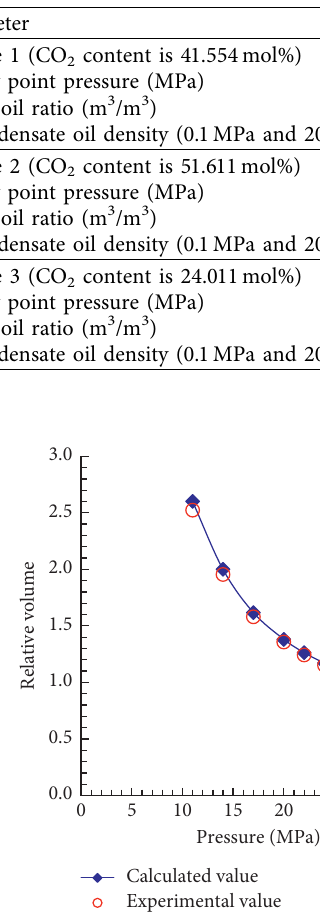
Table 5: Matching results of dew point pressure, gas-oil ratio, and condensate oil density between the experimental data and calculated values.